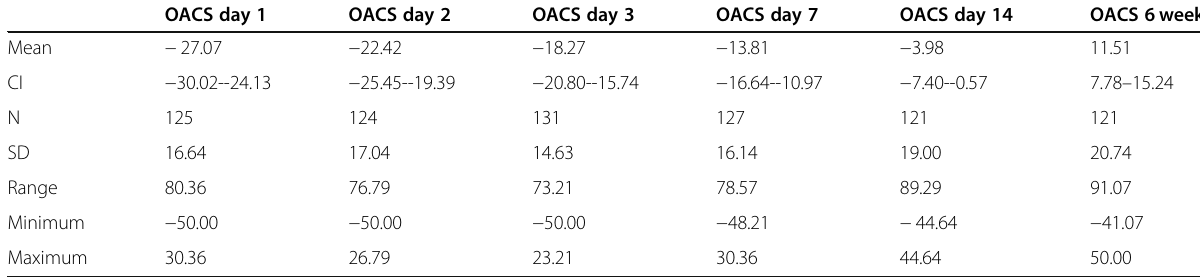
Table 11 Mean overall scores for OACS testing time points